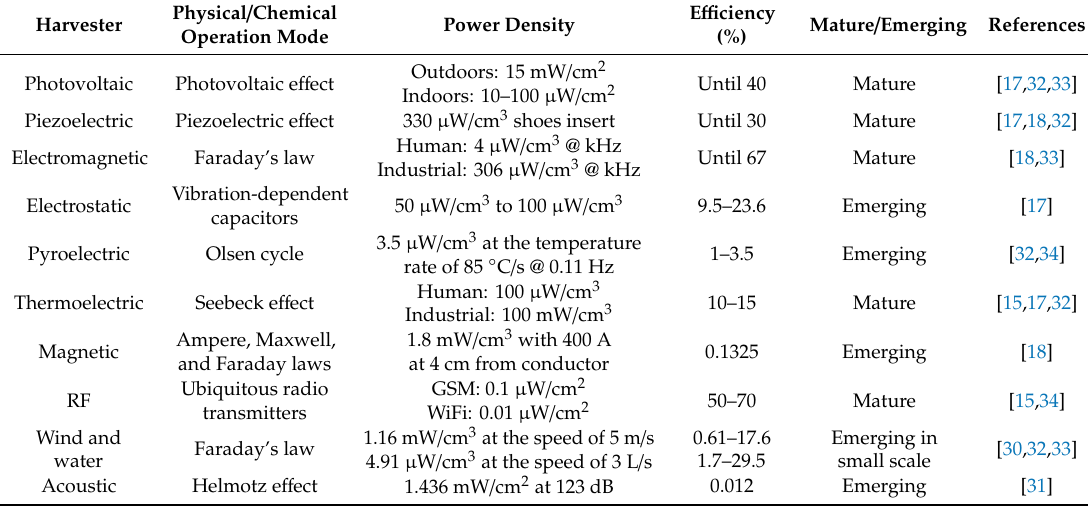
Table 1. Current energy harvesters’ technologies’ characteristics